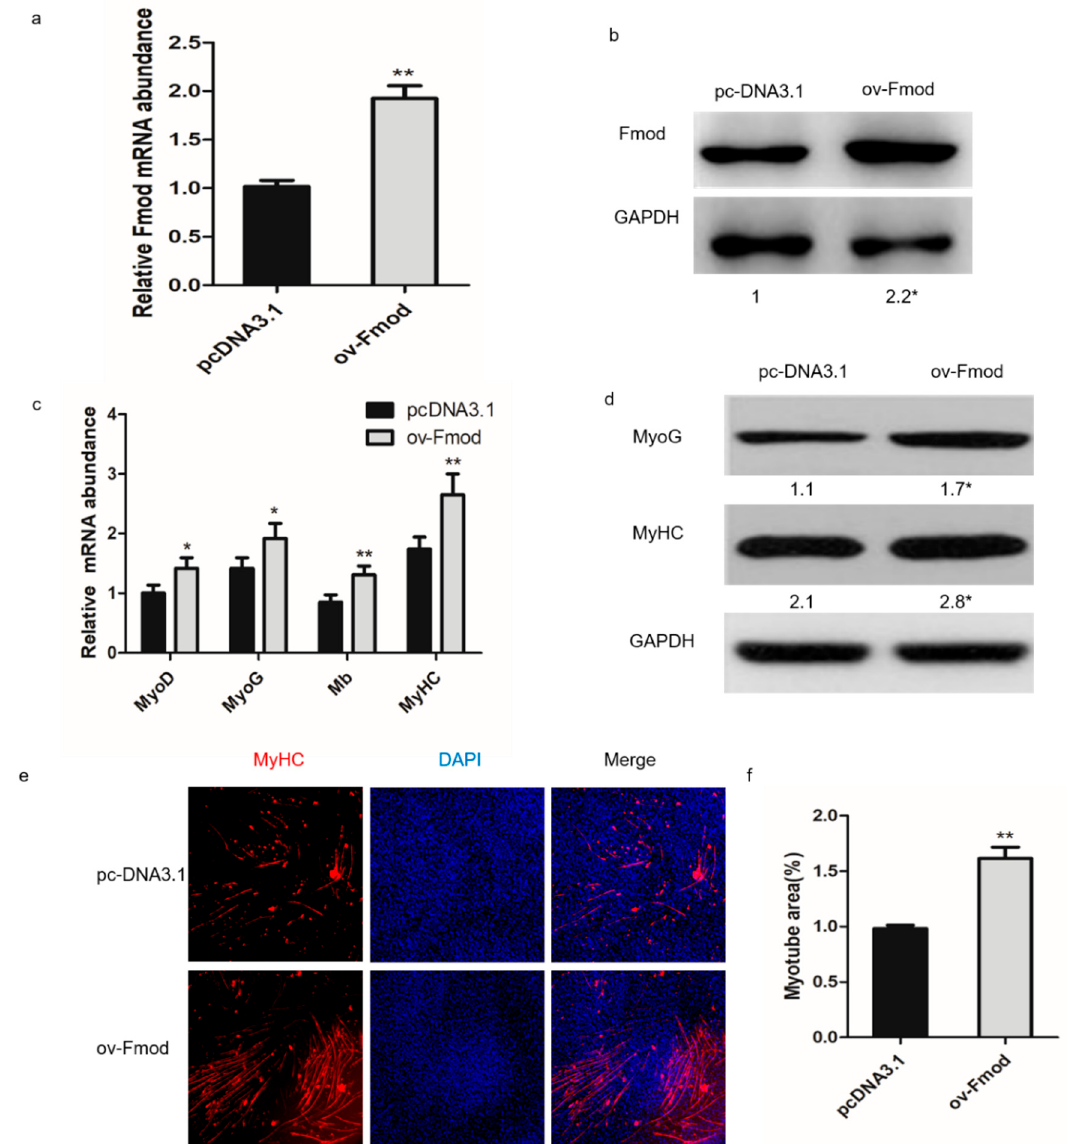
Figure 3. The effect of Fmod overexpression on chicken primary myoblasts differentiation. ( a , b ) The expression of Fmod mRNA and protein levels after transfection with pcDNA3.1 or Fmod overexpression plasmids for 48 h. ( c ) The MyoD, MyoG, Mb, and MyHC mRNA expression levels after transfection for 72 h. ( d ) Western blot analysis of MyoG and MyHC expression levels after transfection for 72 h. ( e ) Immunofluorescence of chicken myoblasts after transfection for 72 h. MyHc: red; DAPI: blue. ( f ) Myotube area (%) in myoblasts after transfection for 72 h. Note: * p < 0.05, ** p < 0.01.